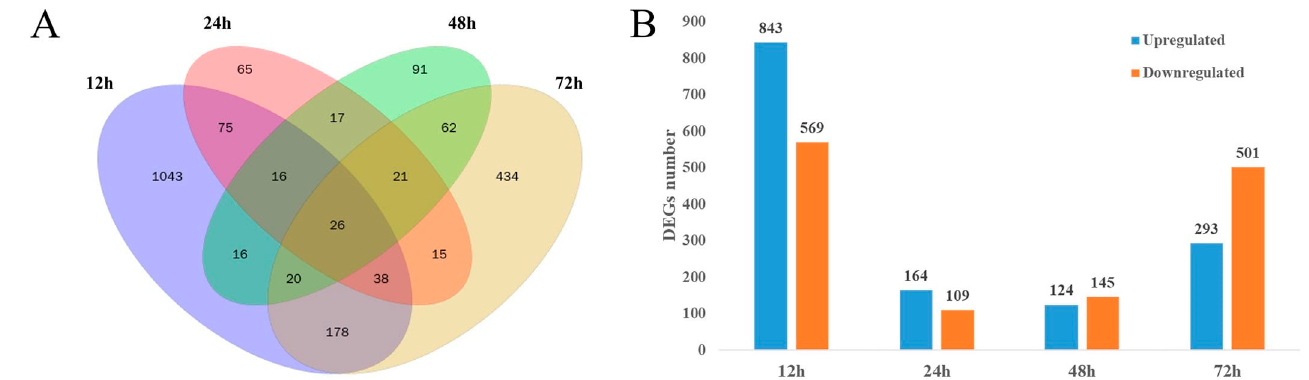
Figure 1. Statistical analysis of DEGs in T. harzianum T4 at different growth stages (12, 24, 48 and 72 h) in the presence of BCCW. ( A ) Venn diagram of DEGs. ( B ) Numbers of upregulated and downregulated DEGs.